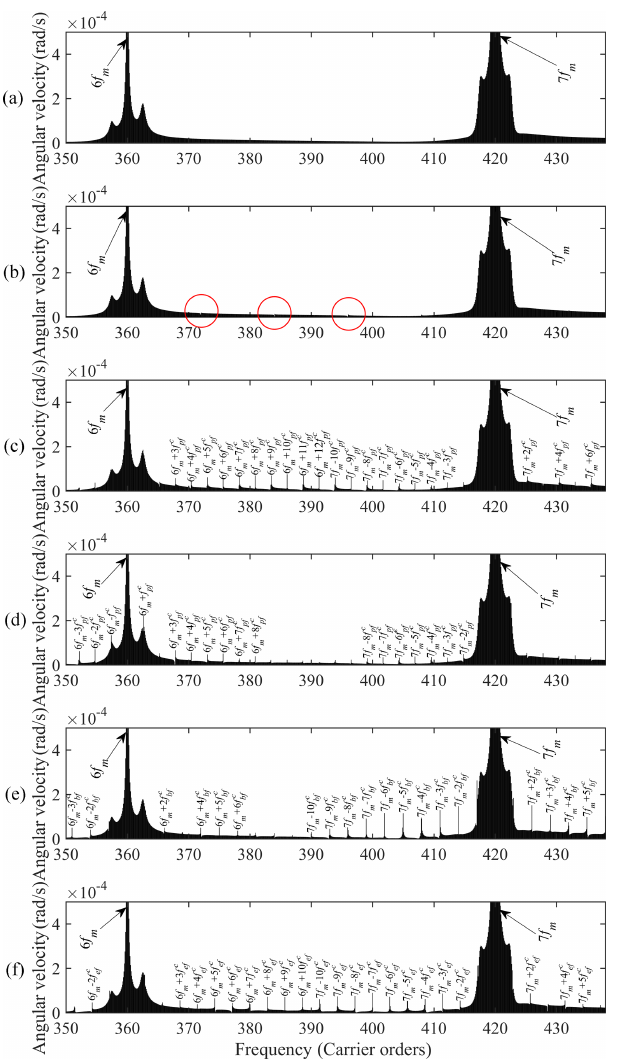
Figure 12. Cepstrum of ring gear e angular velocity signals: (a) healthy gear case, (b) failure case I, (c) failure case II, (d) failure case III, (e) failure case IV, and (f) failure case